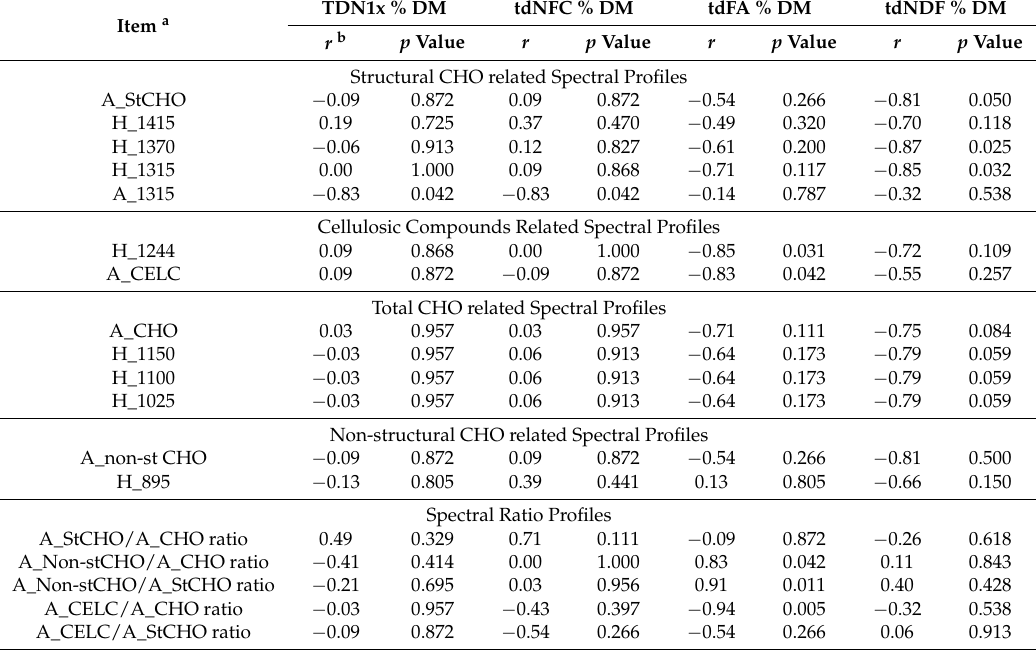
Table 3. Correlation between carbohydrate-related molecular spectral characteristics and truly digestible nutrients in model forage ( Medicago sativa spp . Sativa :